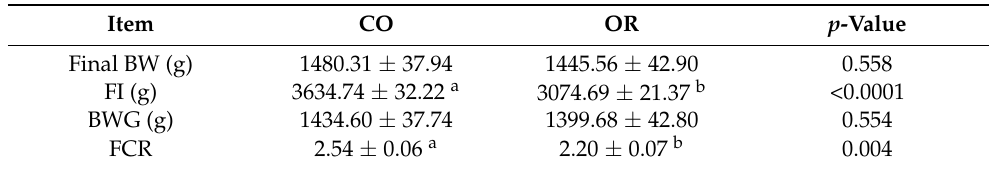
Table 3. Effects of organic raising system on growth performance of Korat chicken at 84 d of age (mean ± SD).